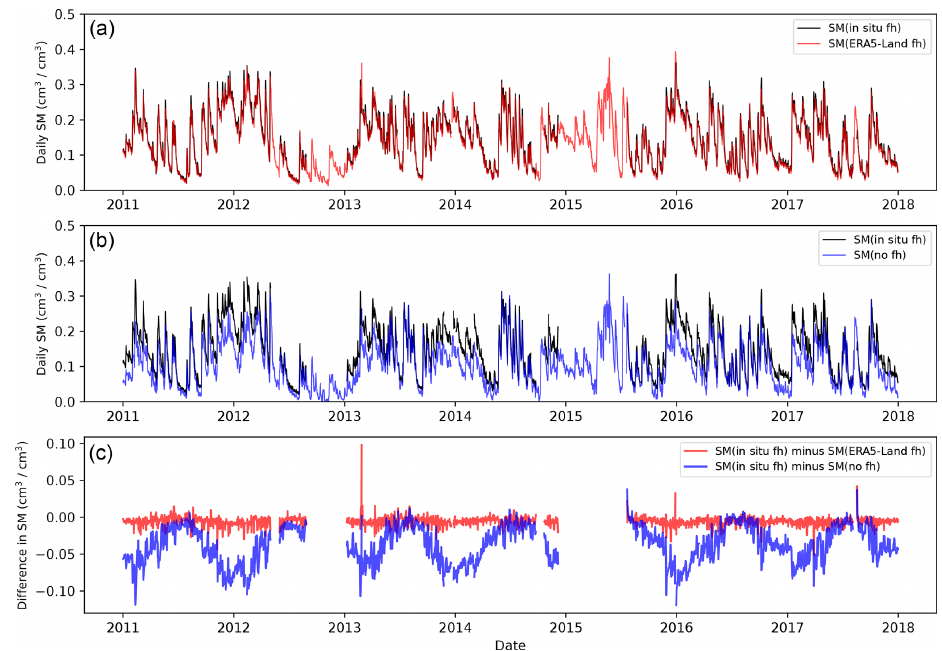
Figure 2. The soil moisture (SM) record at the ARM-1 CRNS site in the USA. Panels (a) and (b) show the SM product when corrected using in situ data in black. The red line in panel (a) is the SM product corrected with ERA5-Land data in place of temperature and relative humidity sensors. The blue line in panel (b) shows the SM product when not correcting for atmospheric water vapour (fh). Panel (c) shows the difference between the SM corrected with in situ data and the alternative correction